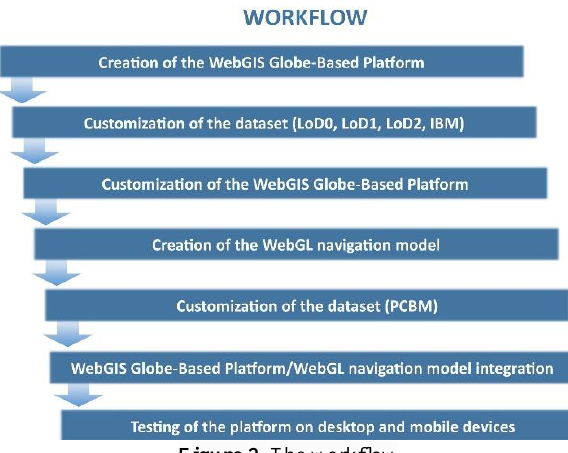
Figure 2 . The workflow